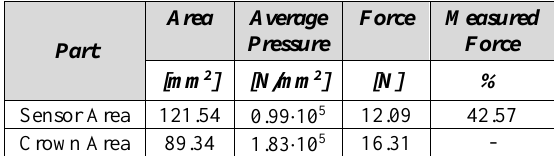
Table 4. Percentage of forces which is applied to the sensor when using the Deep5R6 sensor housing.